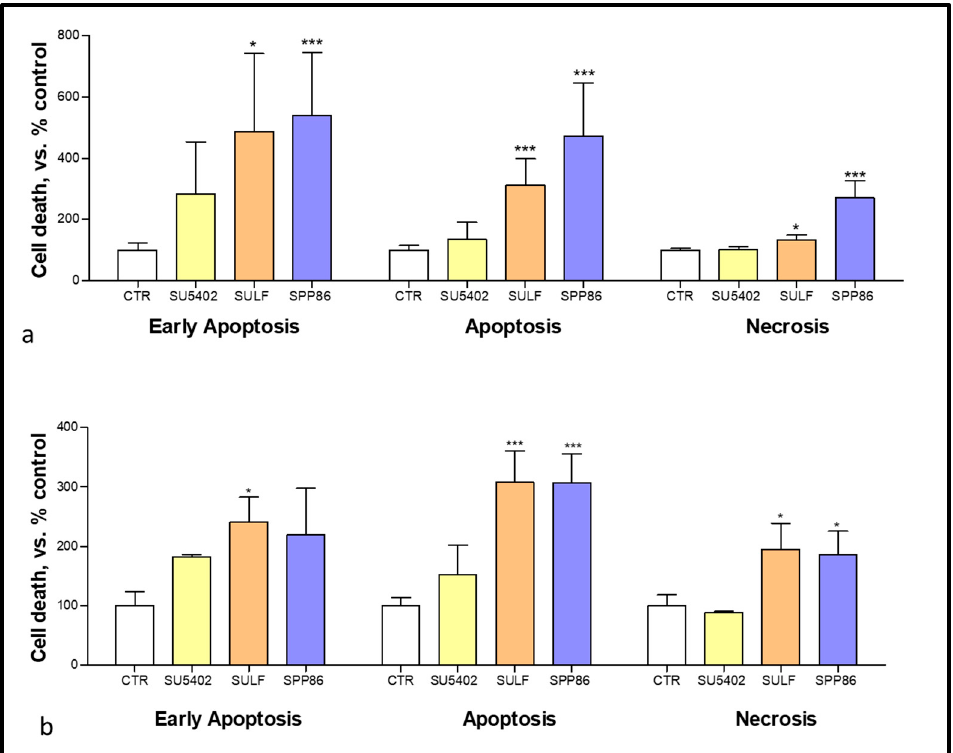
Figure 4. Modulation of cell death analysis after 6 days of incubation with SU5402, SULF and SPP86 in TT ( a ) and MZ-CRC-1 ( b ) cell lines through flow cytometry with annexin V and propidium iodide. The proportions of cells in early apoptosis, late apoptosis and necrosis are expressed as percentage compared with CTR and represent the mean ± standard error of the mean of at least 3 independent experiments. *: p < 0.05, ***: p < 0.001, CTR: control, SULF: sulfatinib.